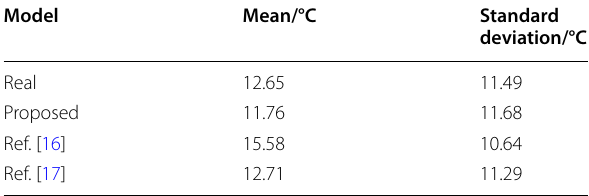
Table 4 Descriptive statistics for simulated temperatures